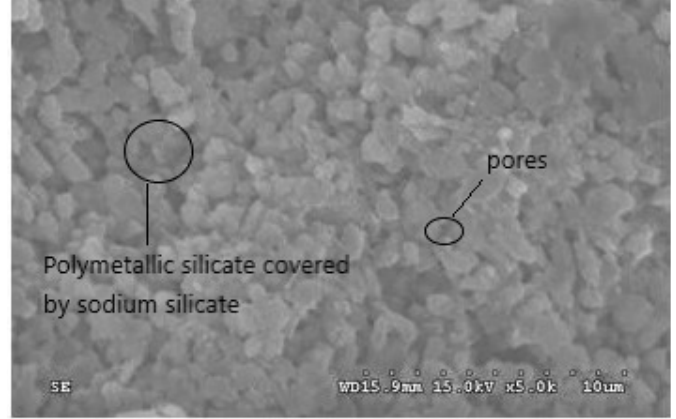
Figure 16. GA5 paste SEM in 5000 k image.